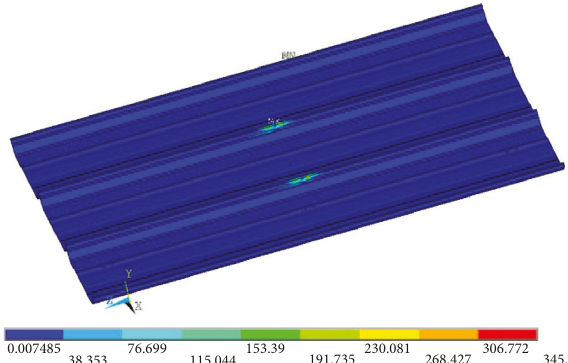
Figure 6: Deformation and stress distribution of the roof